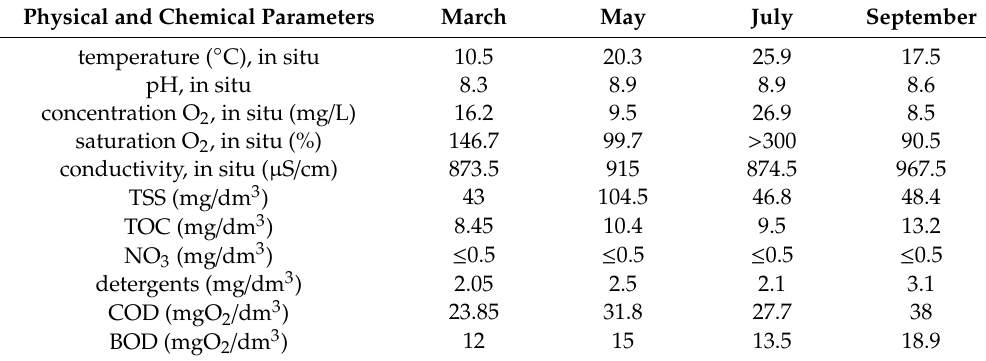
Table 2. Physical and chemical parameters of water from Lake Ludoš in 2018. Physical and Chemical Parameters